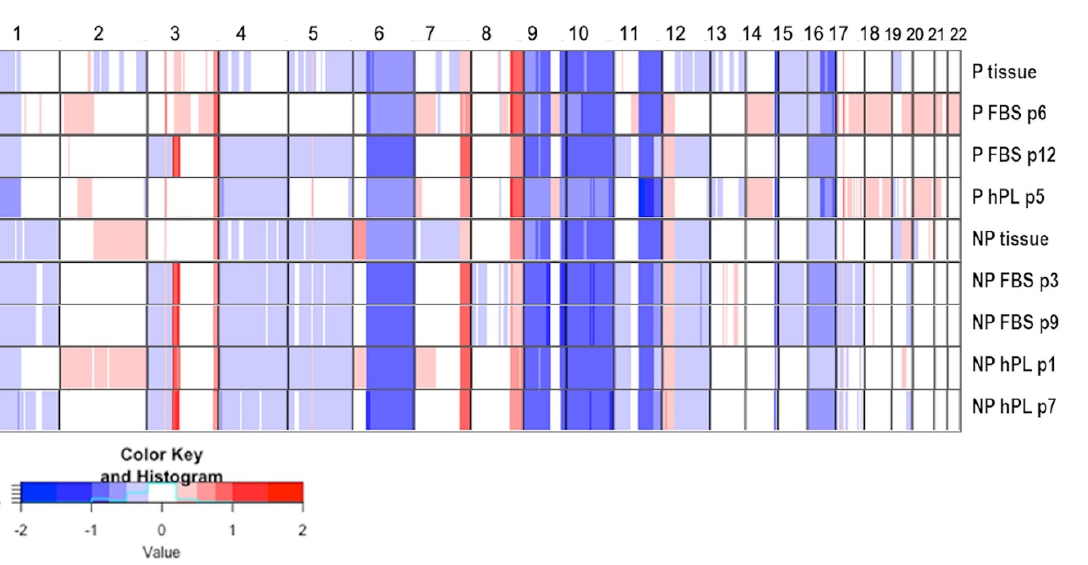
Figure 5. Genome-wide copy number profile of lymph node tissues and corresponding cell lines. Heat map depicting segmented log2-ratios pigmented (P) and non-pigmented (NP) tissues and various passages of their corresponding cell lines cultivated with FBS or hPL. Blue indicates loss of chromosomal material; red indicates gain of chromosomal material.